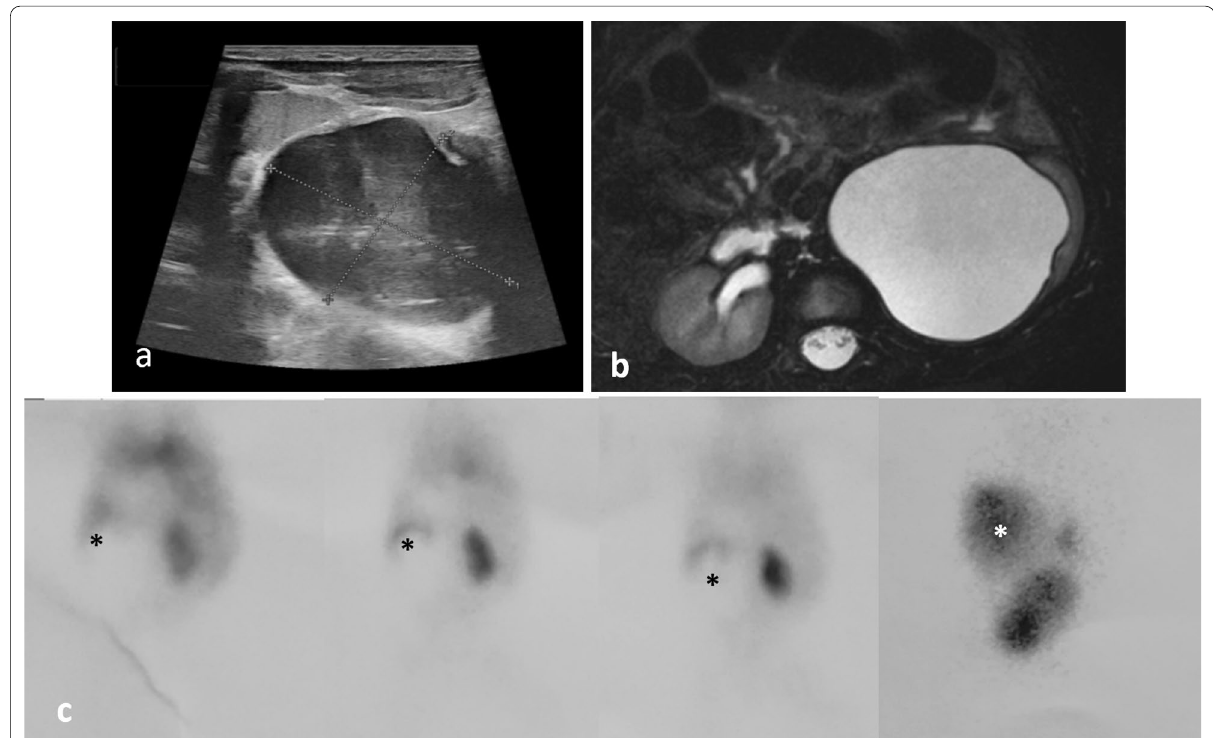
Fig. 3 A case of pelviureteric junction obstruction a ultrasound shows marked dilatation of the renal pelvis with marked thinning of the renal parenchyma. b axial high-resolution T2-WI of MRU protocol reveals dilated renal pelvis with parenchymal thinning, c Dynamic renal scintigraphy shows early photopenic area at the site of renal pelvis which fills of the tracer with time